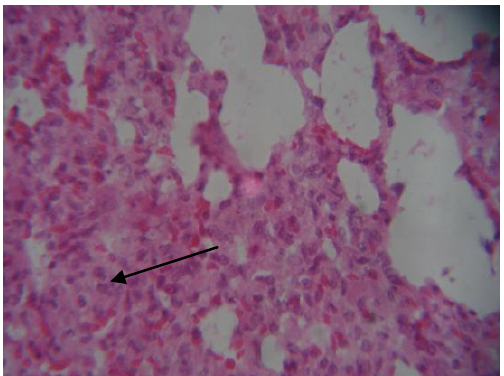
Fig (15): lung at day 6 pi. revels thickening of the inter- alveolar wall due to inflammatory cells & fibranous exudates ( ) ( H&EX10).